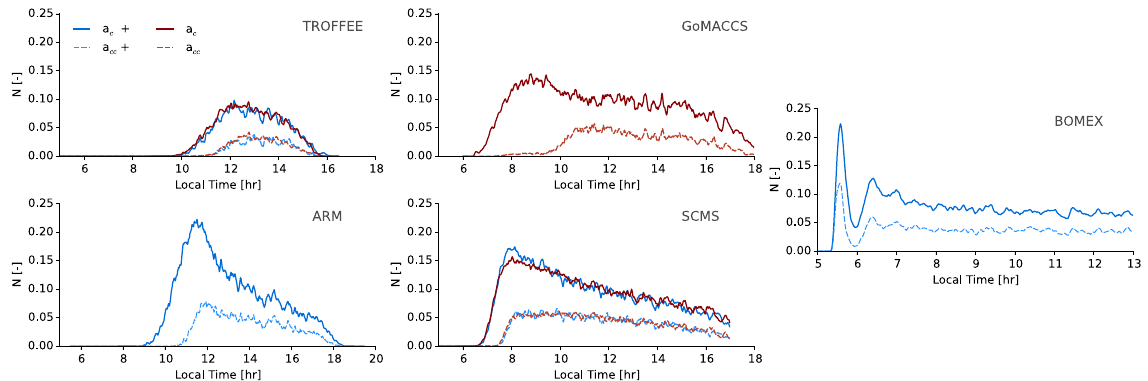
Figure 1. Temporal evolution of the domain-averaged maximum area fraction ( N ) of clouds and cores for the ShCu cases (Table 1). The blue lines denote an experiment with wind (indicated with a “ + ”), while the red lines indicate a free convection case.